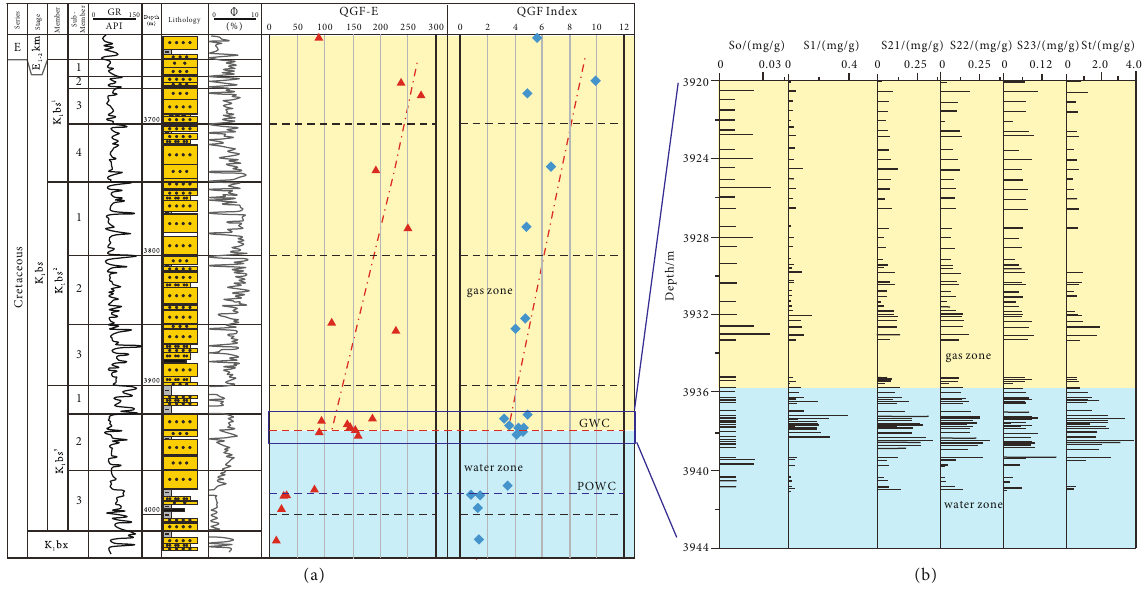
Figure 5: QGF and reservoir pyrolysis pro fi les for the K1bs reservoir in KL201 well, indicating the existence of an ancient oil reservoir. (a) QGF and QGF – E pro fi les for well KL201, showing the POWC below the GWC. (b) Reservoir pyrolysis pro fi le showing the characteristics of oil layers in both the gas and water zones. S , S , S , S , and S represent hydrocarbons detected in unit mass reservoir rocks at < 90 ° C, 90 – 0 1 21 22 23 200 ° C, 200 – 350 ° C, 350 – 4500 ° C, and 450 – 600 0 ° C, respectively, and S t represents the total hydrocarbons in a unit mass of rock (the sum of S , S , S , S , and S 1 21 22 23 2912 cm − 1 , representing late overmature and overpressur- ized dry gas charging.